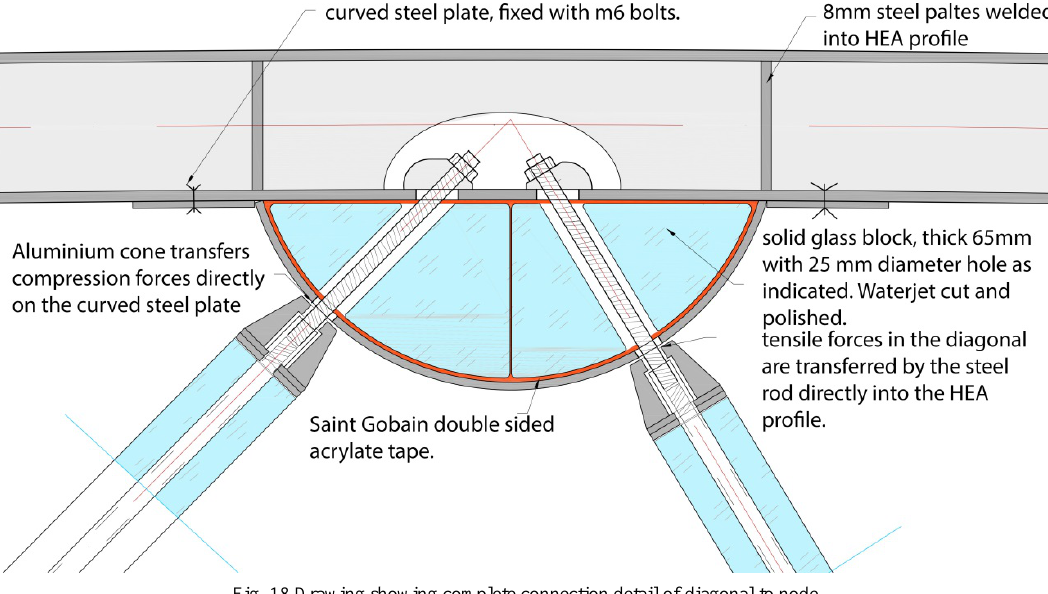
Fig. 18 Drawing showing complete connection detail of diagonal to node.